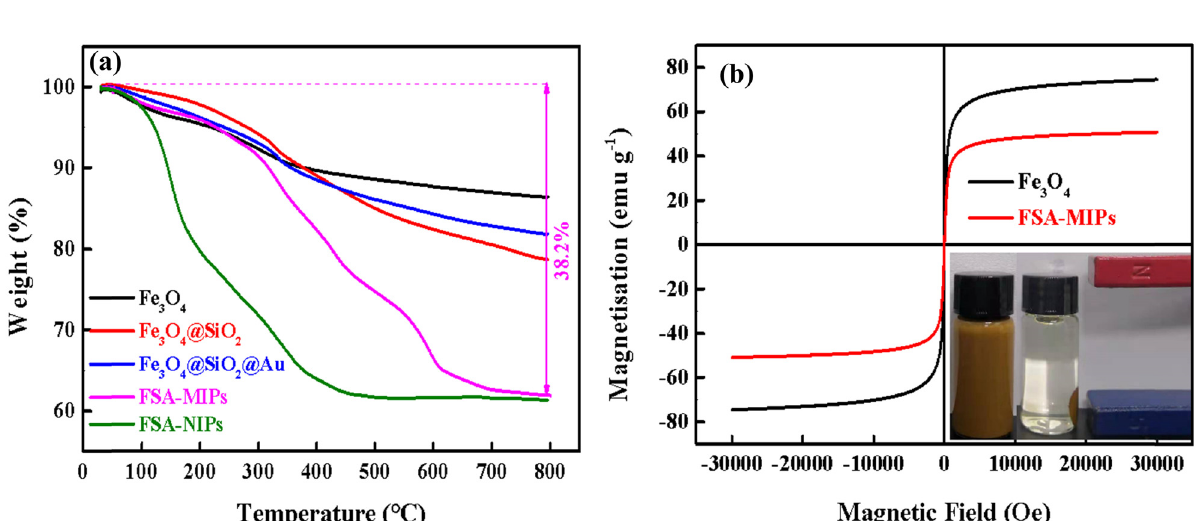
Figure A2: ( a ) TGA curves of Fe 3 O 4 , Fe 3 O 4 @SiO 2 , Fe 3 O 4 @SiO 2 @Au, FSA - MIPs, and FSA - NIPs in the range of 30 – 800°C. ( b ) The magnetic hysteresis loops of Fe 3 O 4 and FSA - MIPs.